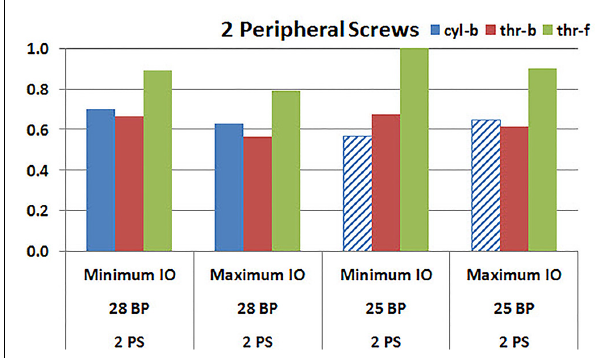
FIGURE 9 | Interfacial micromotion results using Minimum and Maximum inferior offset (Minimum IO and Maximum IO); and 28 mm and 25 mm baseplates (28 BP and 25 BP), with two peripheral screws. The patterned bars represent the predictions where the primary trend (maximum inferior offset resulted in reduced micromotion) was reversed.